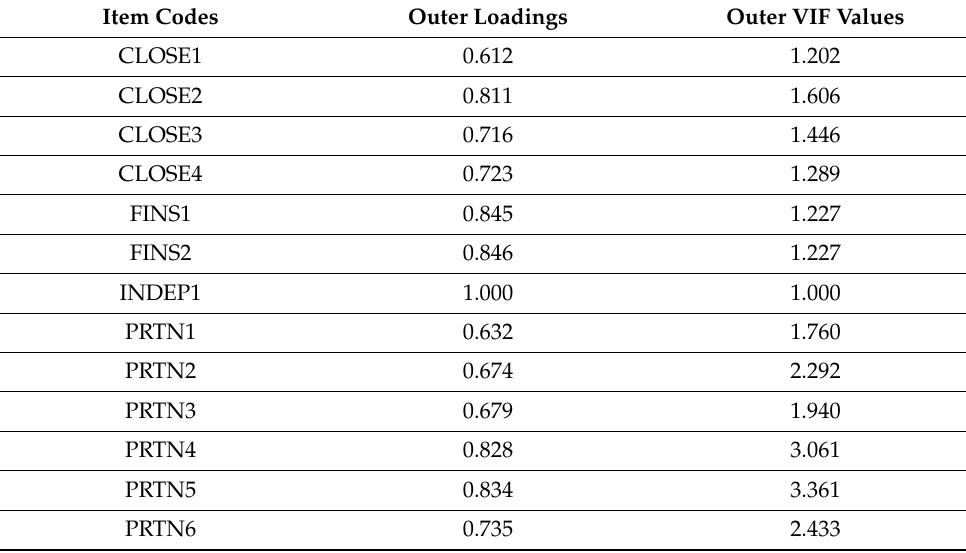
Table 3. Items’ outer loadings and outer VIF